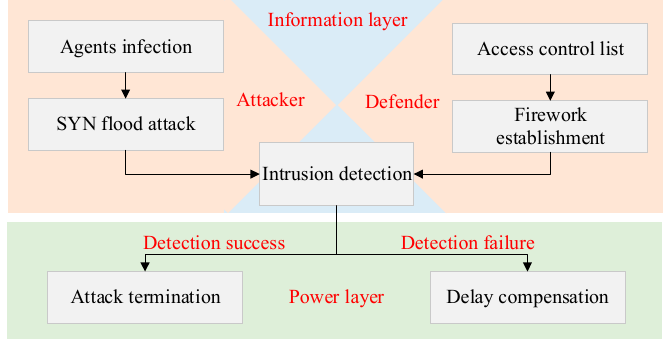
Figure 6. Coordinated defense framework of CPPS.